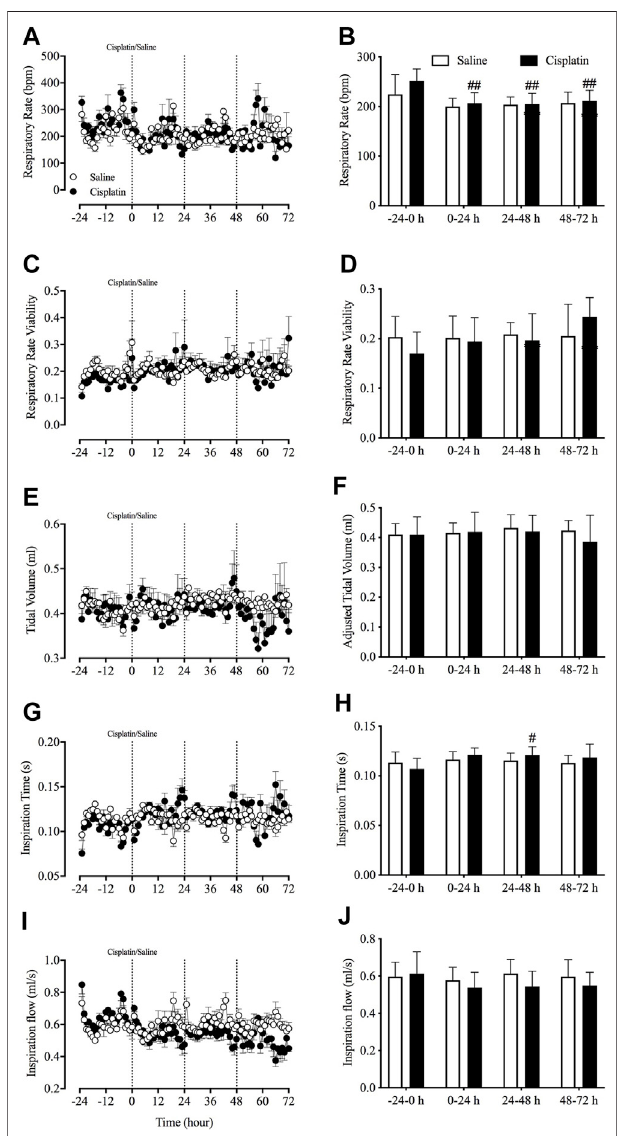
FIGURE 6 | Effect of cisplatin (30 mg/kg, intraperitoneal) on respiratory activity in Suncus murinus . (A) Respiratory rate in breaths per min (bpm); (B) change inrespiratory rate averaged over 24 h; (C) respiratory rate viability; (D) change in respiratory rate viability averaged over 24 h; (E) adjusted tidal volume; (F) change in adjusted tidal volume averaged over 24 h; (G) inspiration time; (H) change in inspiration time averaged over 24 h; (I) inspiration fl ow; and (J) change in inspiration fl ow averaged over 24 h. Data are means ± standard errors of the mean for n (cid:1) 7 – 8 animals. Signi fi cant differences relative to baseline ( − 24 – 0 h) in each group are shown as # p < 0.05, or ## p < 0.01 [two-way analysis of variance (ANOVA) followed by Bonferroni tests]. There was no signi fi cant difference between the two groups p > 0.05 (two-way ANOVA followed by Bonferroni tests).